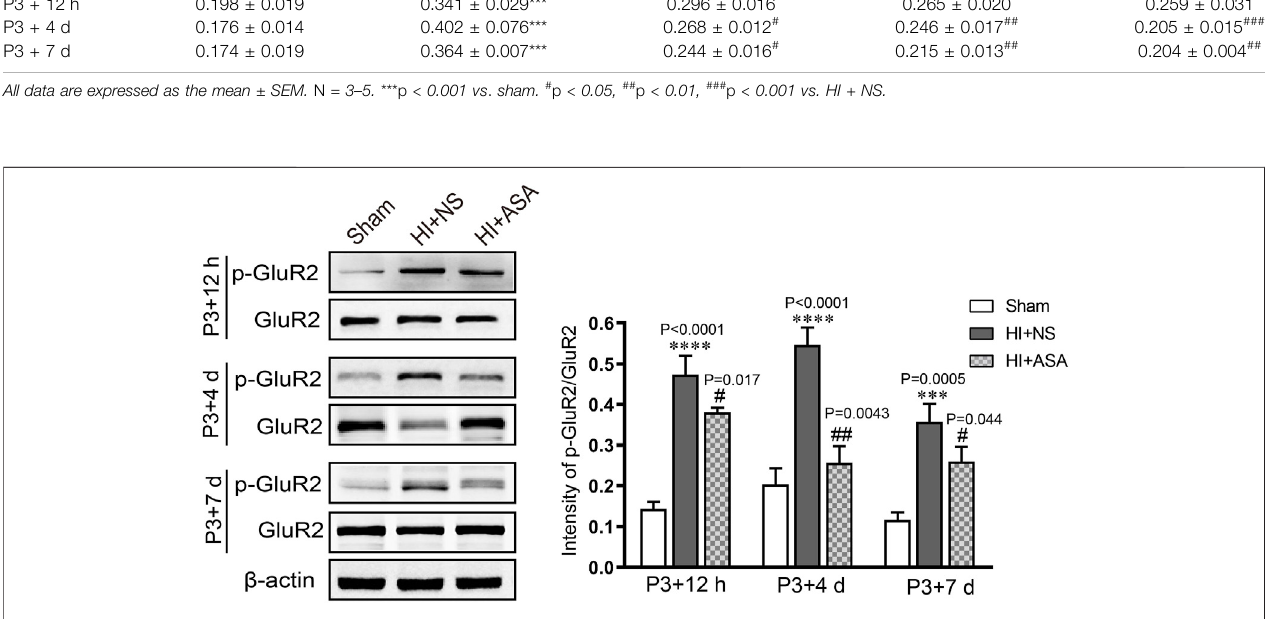
FIGURE3| α -AsaronolinhibitsHI-inducedactivationoftheionotropicglutamatereceptorAMPAR.Theproteinlevelofp-GluR2(subunit2ofAMPAR)wasdetected by western blot at P3 + 12 h, P3 + 4 d, and P3 + 7 d after HI. HI induced an obvious increase in p-GluR2 (Tyr876), and α -asaronol (50 mg/kg) treatment decreased the level of p-GluR2. All data are expressed as the mean ± SEM. ***p < 0.001, **** p < 0.0001 vs. sham. # p < 0.05, ## p < 0.01 vs. HI + NS. N = 4 for each